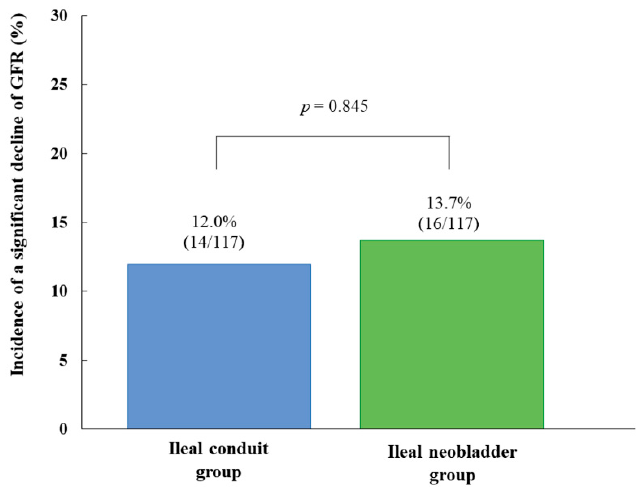
Figure 2. Comparison of the incidence of a significant decline in the GFR between ileal conduit group and ileal neobladder group 12 months after radical cystectomy. A significant decline in the GFR was defined as a ≥ 30% decline in baseline GFR after 12 months. Note that the incidence of a significant decline in the GFR was not significantly different between the two groups. GFR, glomerular filtration rate.